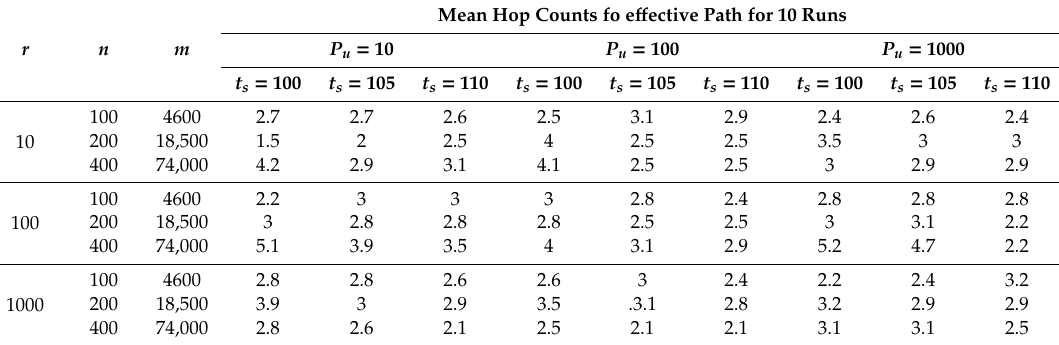
Table 9. Mean hop counts for the e ff ective path for the SESE algorithm for 1 Mb